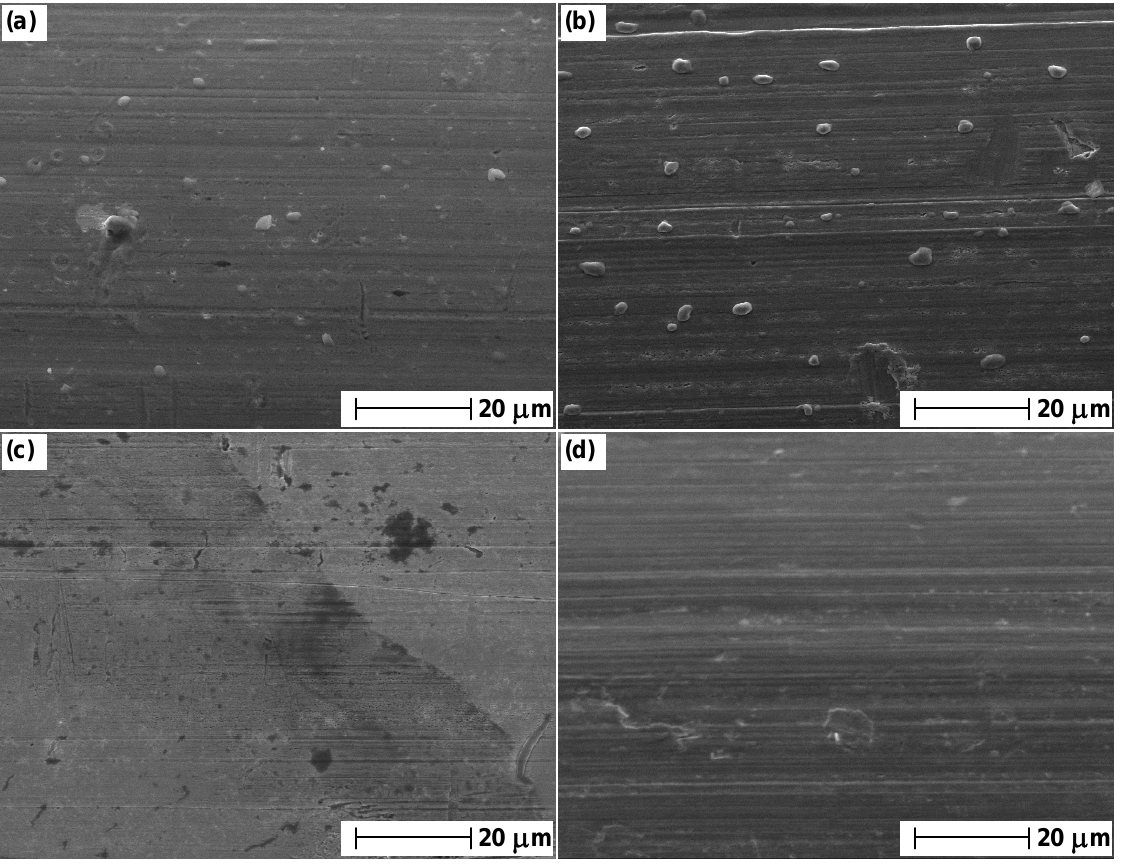
Figure 5. SEM images of Ag wire following a 2 hour annealing step in (a) air at 100  C, (b) air at 400  C, (c) nitrogen at 100  C and (d) nitrogen at 400  C. In each case the wire was placed in an atmosphere of